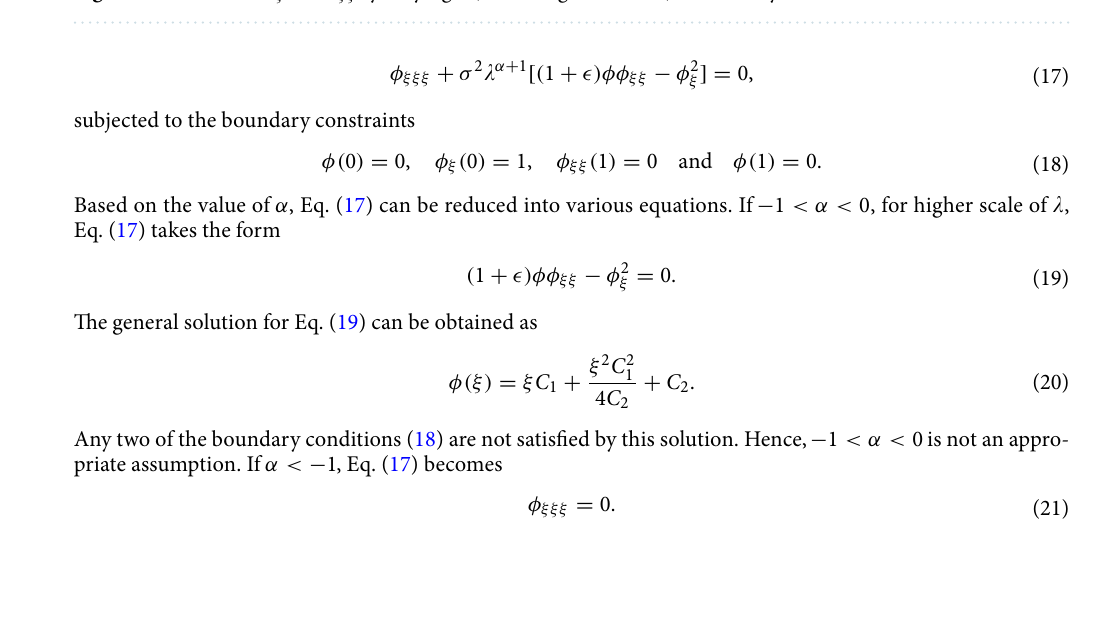
Figure 2. Plots of F , F ξ and F ξξ by varying (cid:31) (stretching wall (cid:31) > 0 ) in the axisymmetric